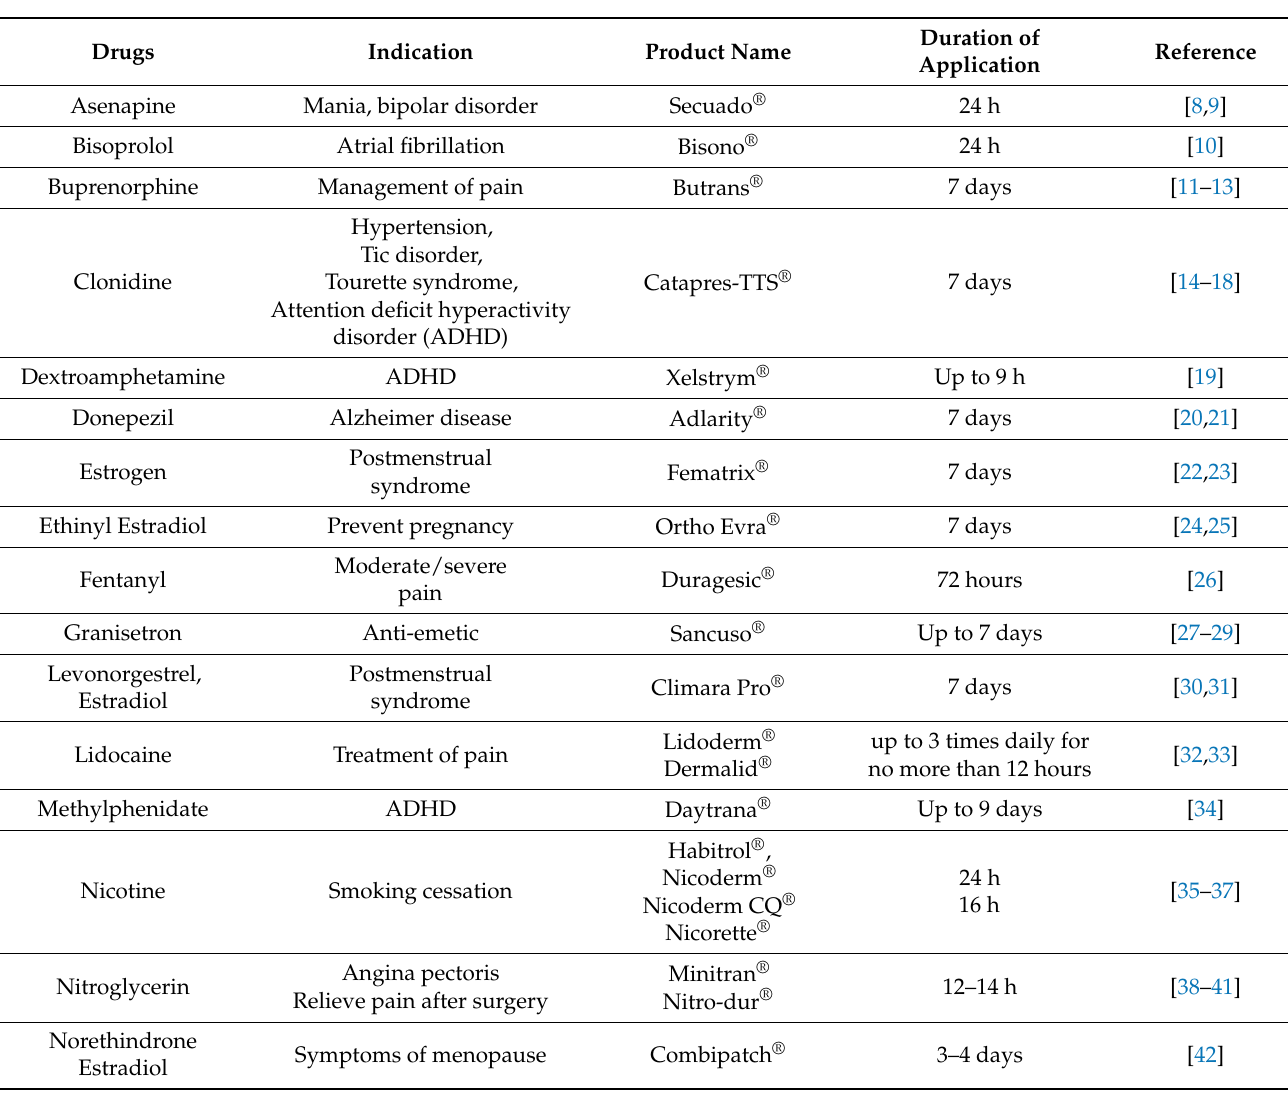
Table 2. A summary of transdermal patches/products and their unique